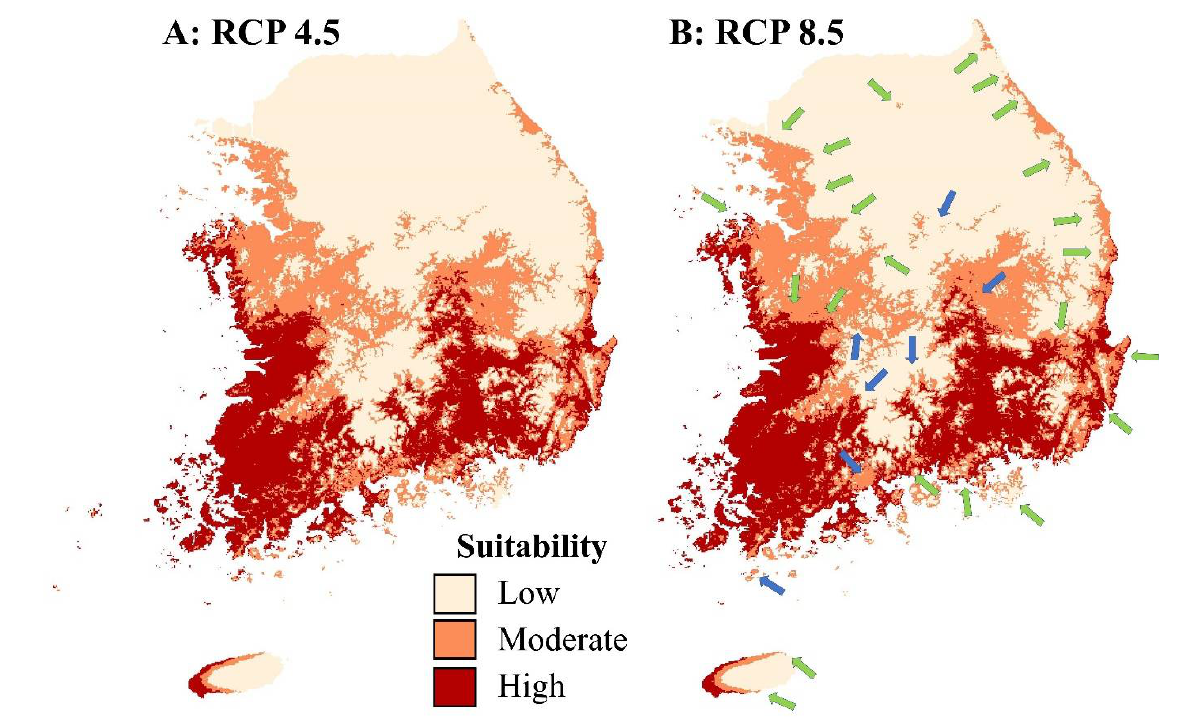
Figure 2. Changes in the distribution of Lithobates catesbeianus in the climate change scenarios. ( A ) RCP 4.5, ( B ) RCP 8.5. The arrows indicate the increase (green) and decrease (blue) of predicted distribution in the future.